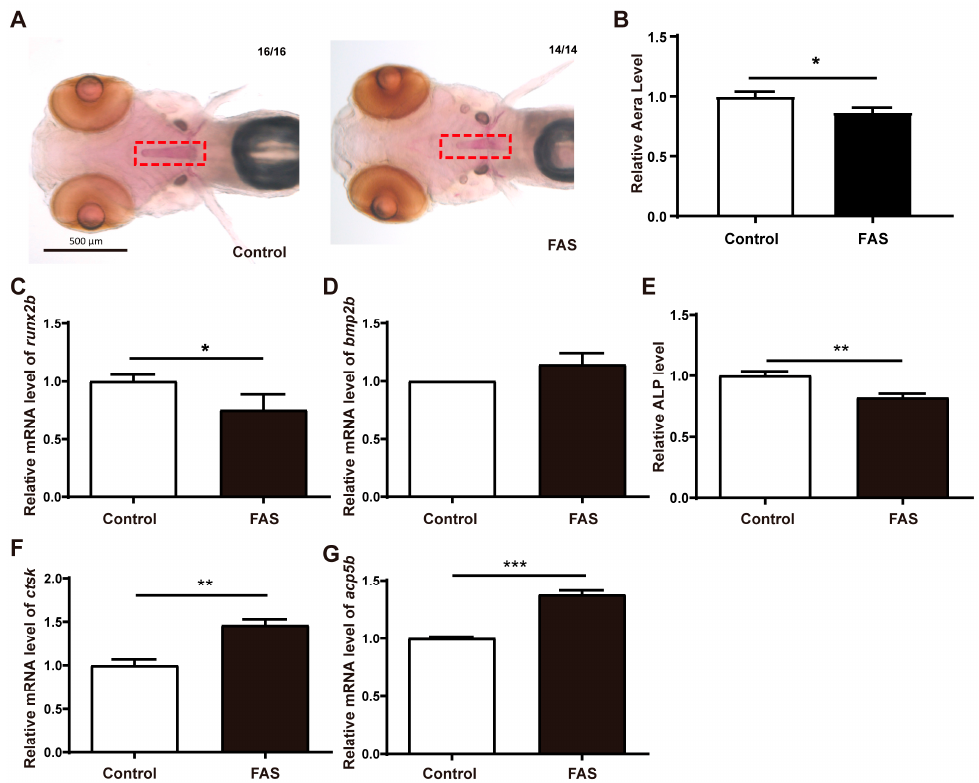
Figure 1. Establishment of iron overload osteoporosis model. ( A ). Alizarin red staining, The red rectangle is the location of osteoporosis. ( B ). Numerical analysis of staining area (unit: pixel), Effect of FAS on genes osteoblast-regulated genes, ( C ). runx2b , ( D ). bmp2b , ( E ). The content of ALP, Effect of FAS on osteoclast-regulated genes, ( F ). ctsk , ( G ). acp5b , ( n = 3, t -test, * p < 0.05, ** p < 0.01, *** p < 0.001, **** p < 0.0001).